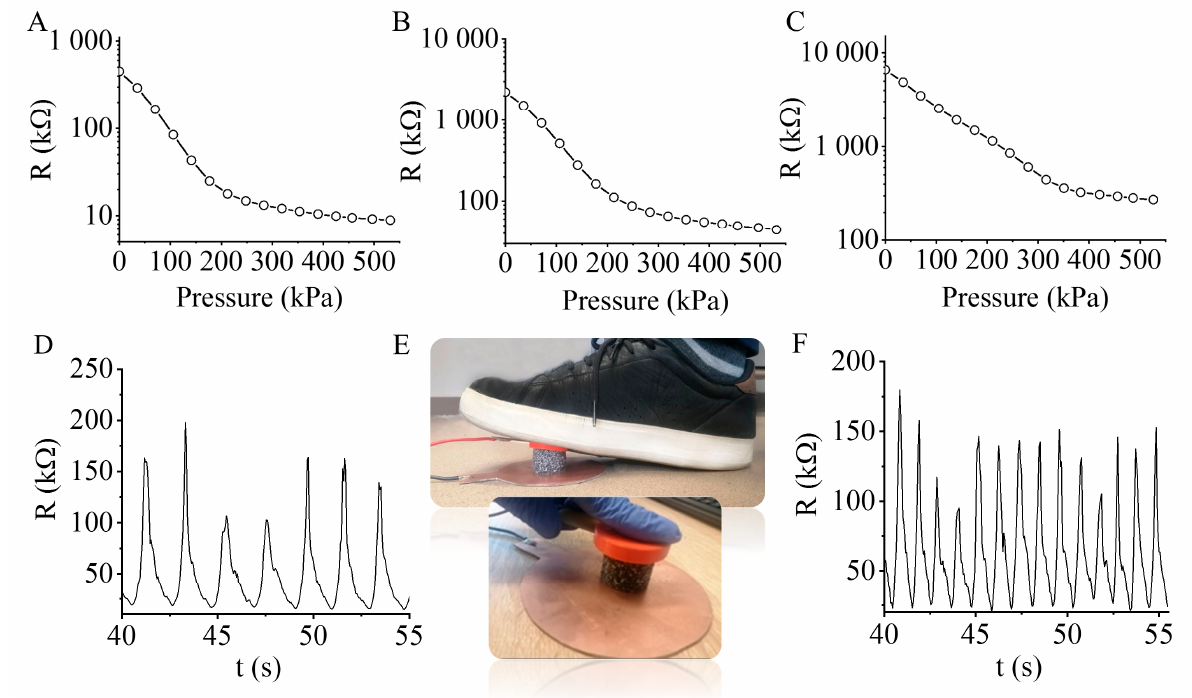
Figure 5. Resistance (k Ω ) versus pressure (kPa) of the prepared N-BCNT/PU-silicone rubber systems: ( A ) sample 1, ( B ) sample 2, and ( C ) sample 3. Motion detection results ( D ) and its test ( E ), and signals of the finger touch detection ( F ) with the developed N-BCNT/PU-silicone rubber nanocomposite.